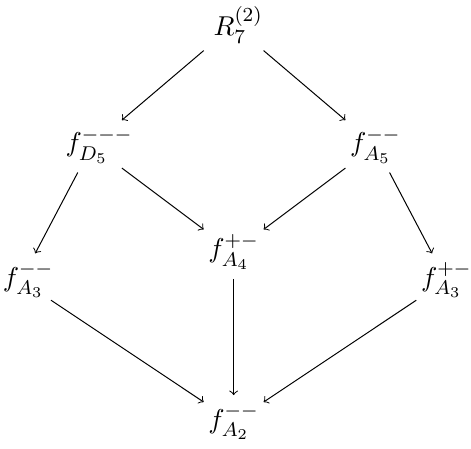
Figure 7. The various pathways along which R (2)